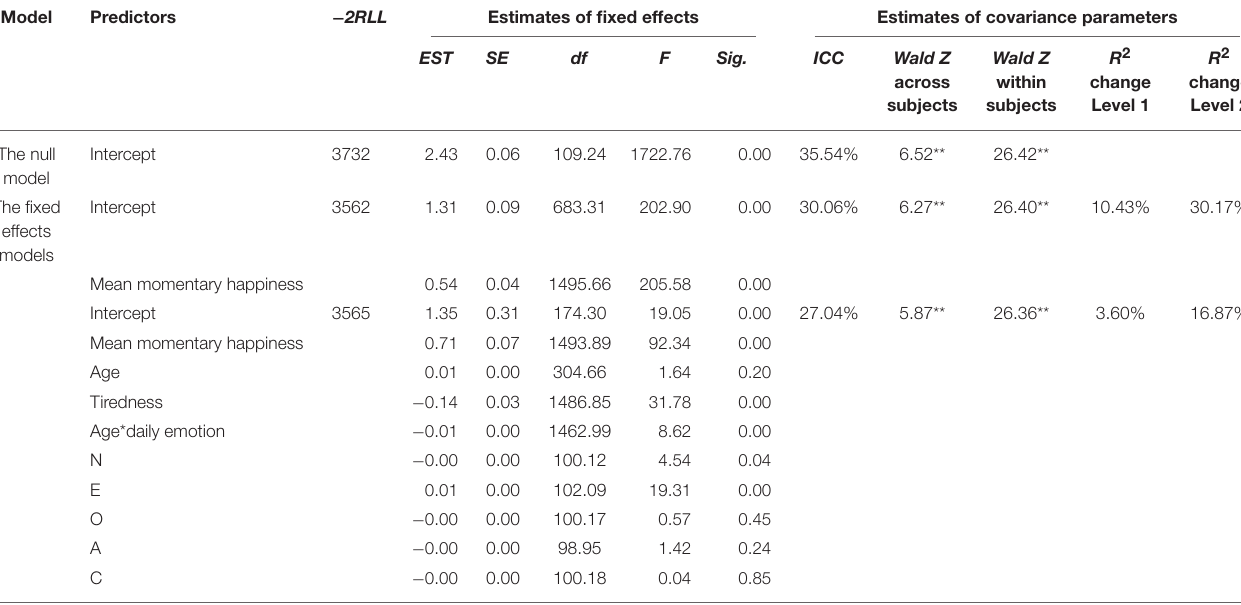
TABLE 4 | The evening ratings of happiness—results of the mixed models analysis of the null model and fixed effects random intercept model.